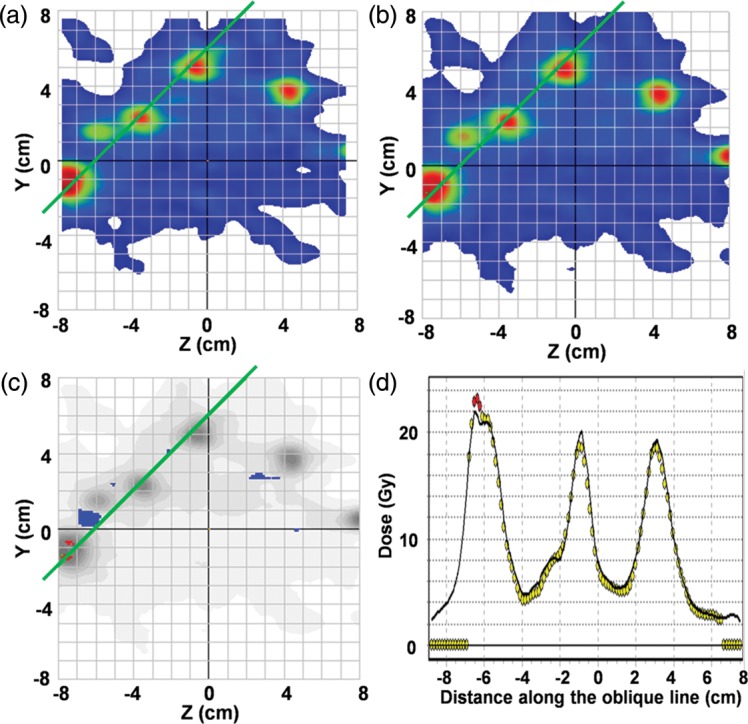
Film analysis result on a sagittal plane at −20 mm for the 14-mets plan: (a) a colored map of a measured dose distribution, (b) a colored map of a calculated dose distribution, (c) an absolute dose gamma plot under a 3%/3 mm criterion with a dose threshold of 30% of the maximum measured dose on the film plane, and (d) a comparison of the dose on an oblique green line indicated in Figs 5a–c. Circles and line show measurement and calculation, respectively.